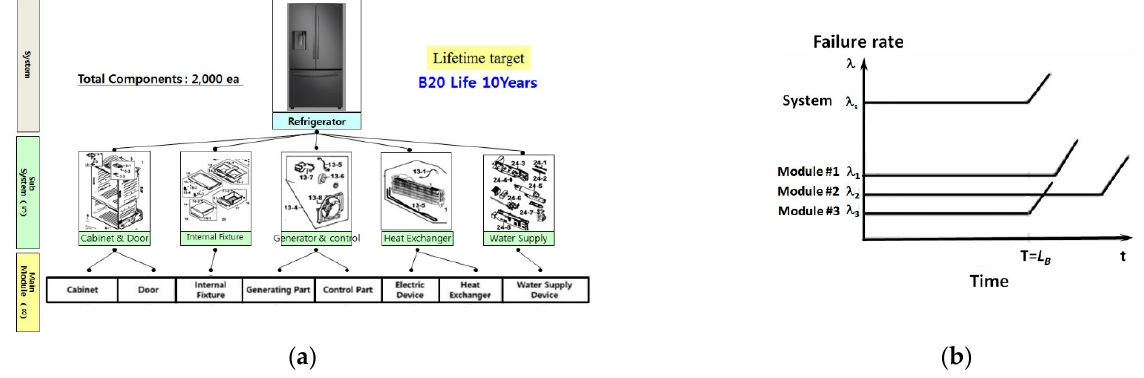
Figure 1. Product lifetime decided by newly designed module ( a ) categorization of multi-module refrigerator; ( b ) product lifetime L B and failure rate λ s .